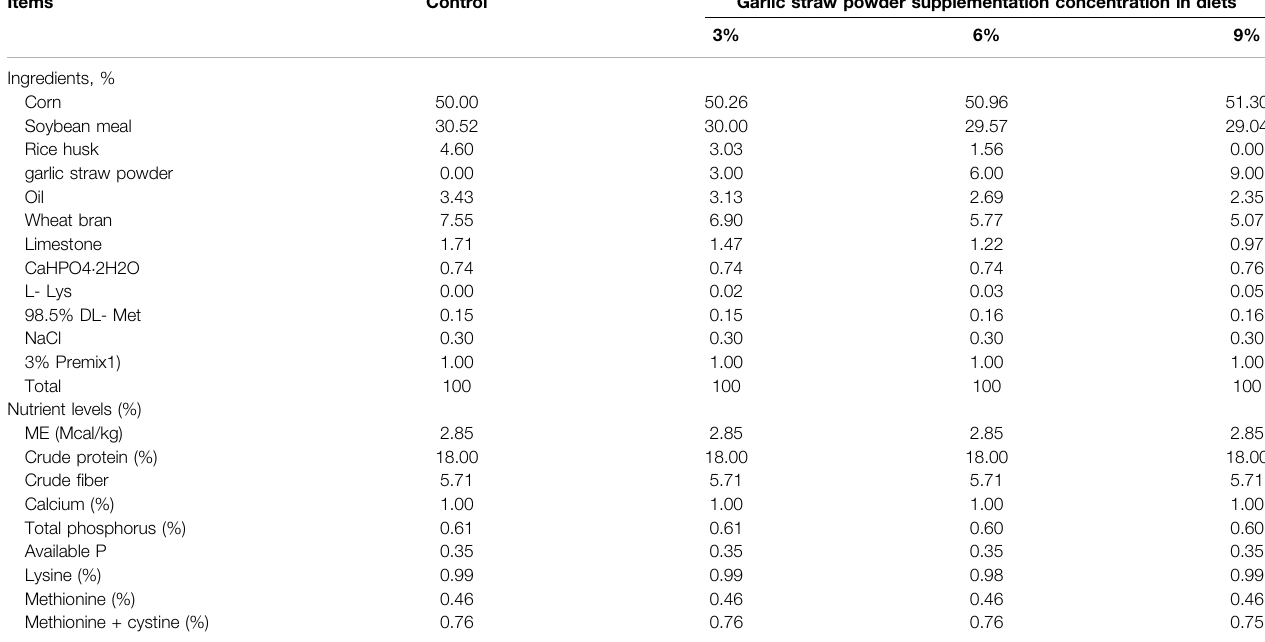
TABLE 1 | Diet formulation and calculated nutrients (as fed basis).